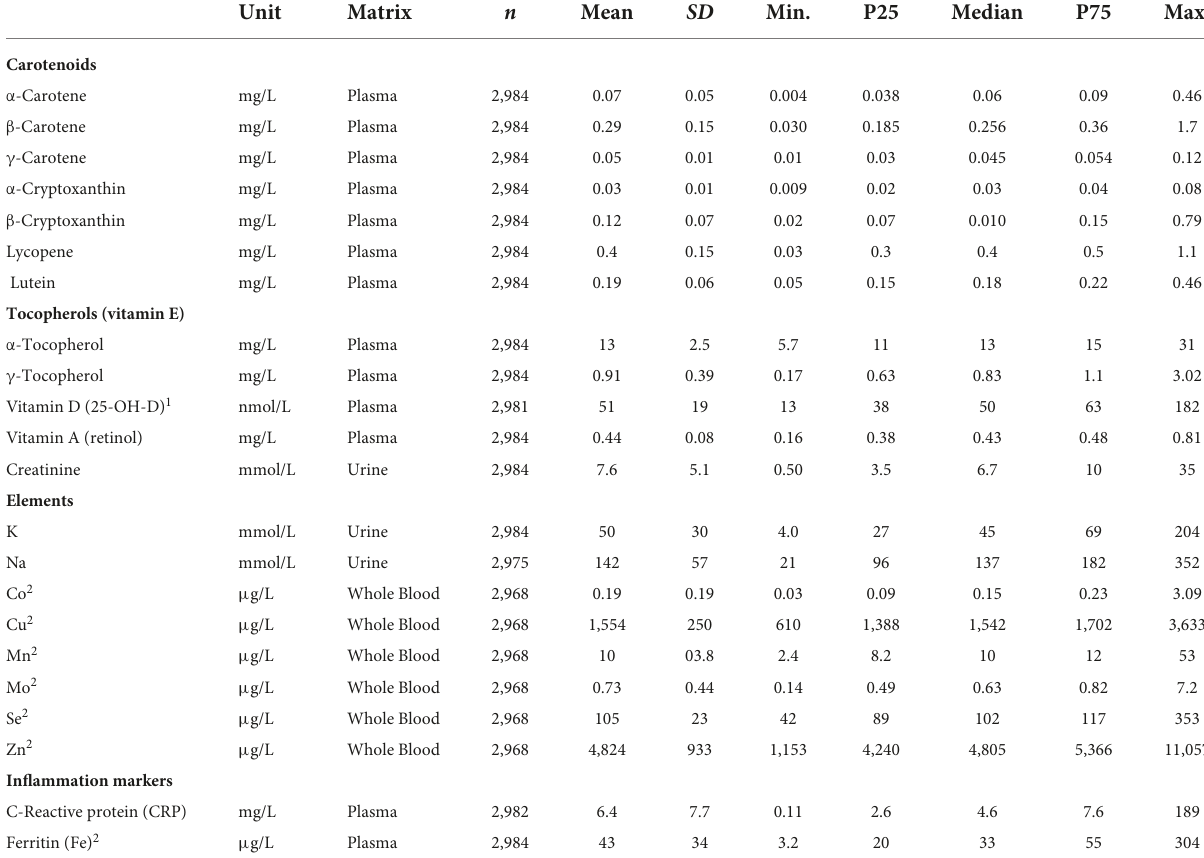
TABLE 2 Summary statistics of biomarker concentrations measured in mid-pregnancy blood and urine samples ( n = 2,984).